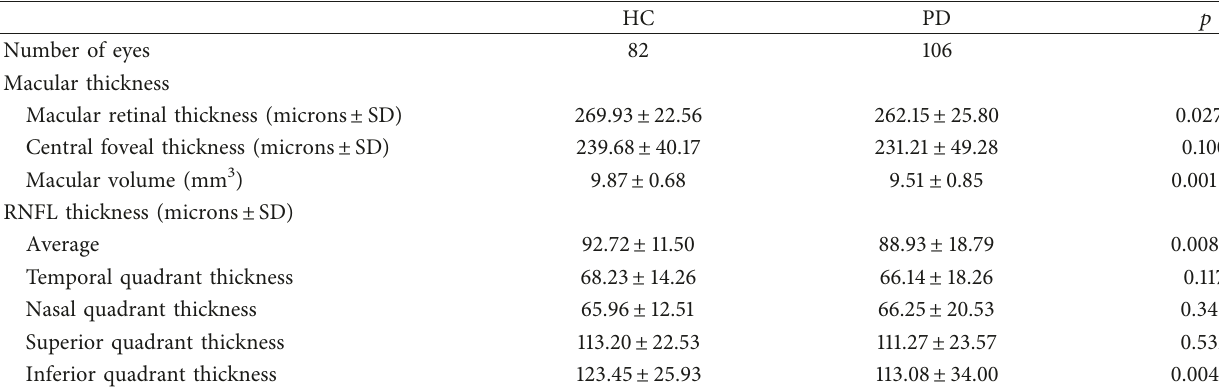
Table 3: Macular thickness, macular volume, and RNFL thickness analysis using SD-OCT.